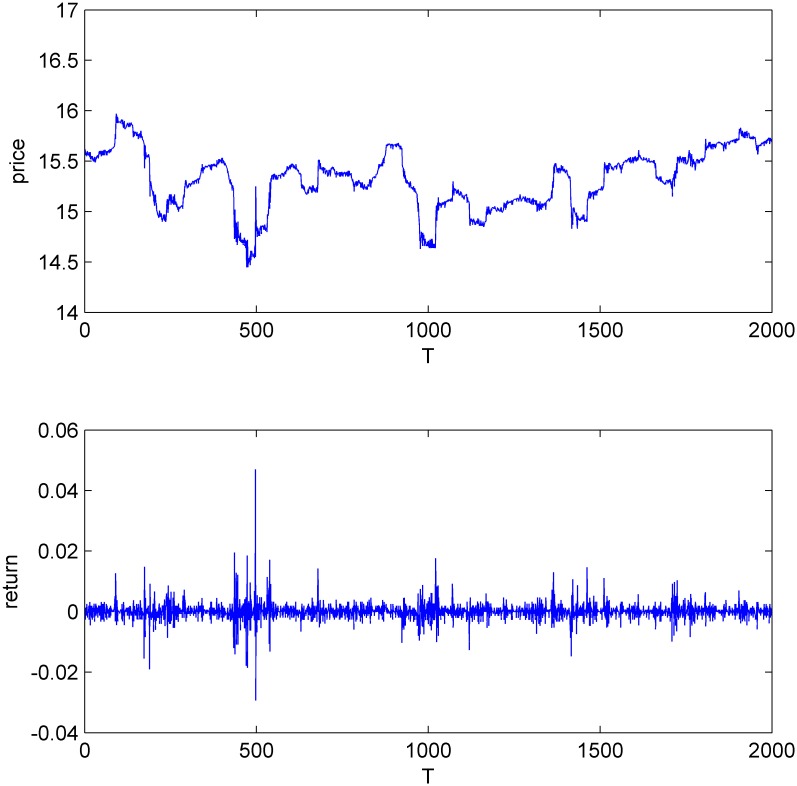
The price and return series of CDA.